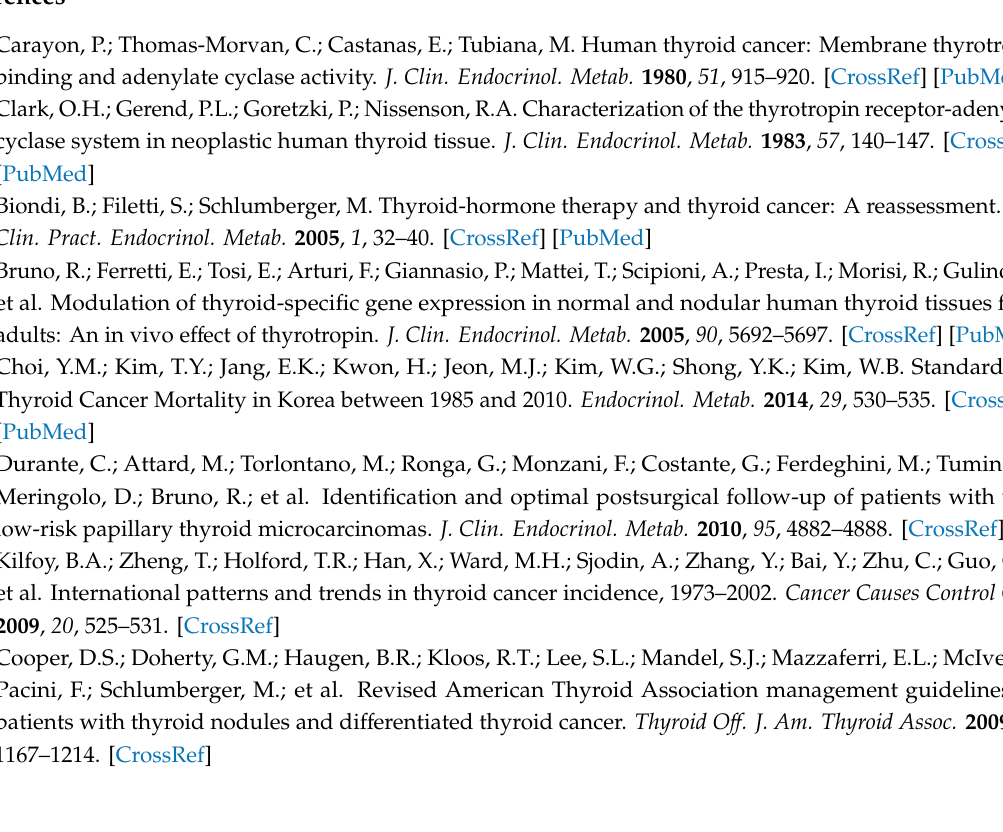
Table S1: Baseline characteristics of patients who excluded from this